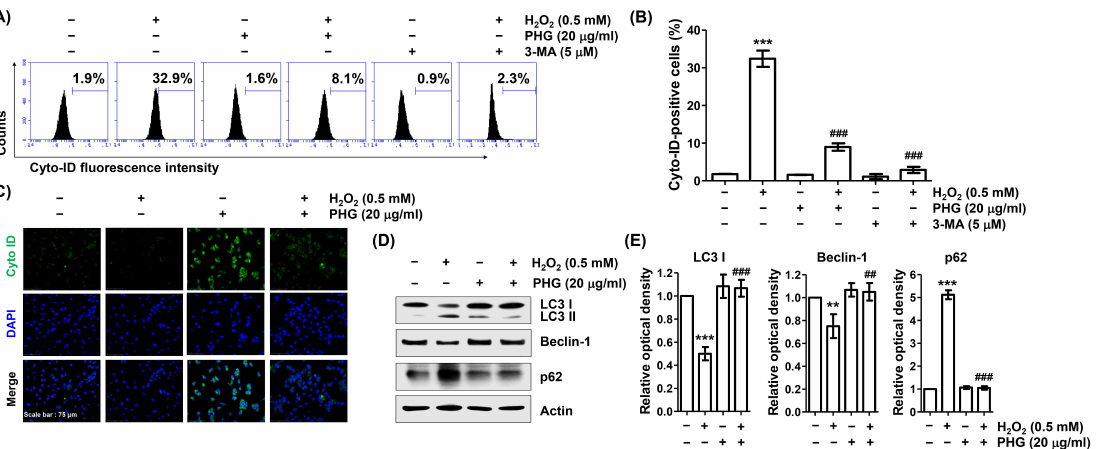
Figure 7. Phloroglucinol attenuates ARPE-19 cells against H 2 O 2 -induced autophagy. ( A , B ) Cells were incubated with phloroglucinol or 3-MA for 1 h and then treated with H 2 O 2 for 24 h,